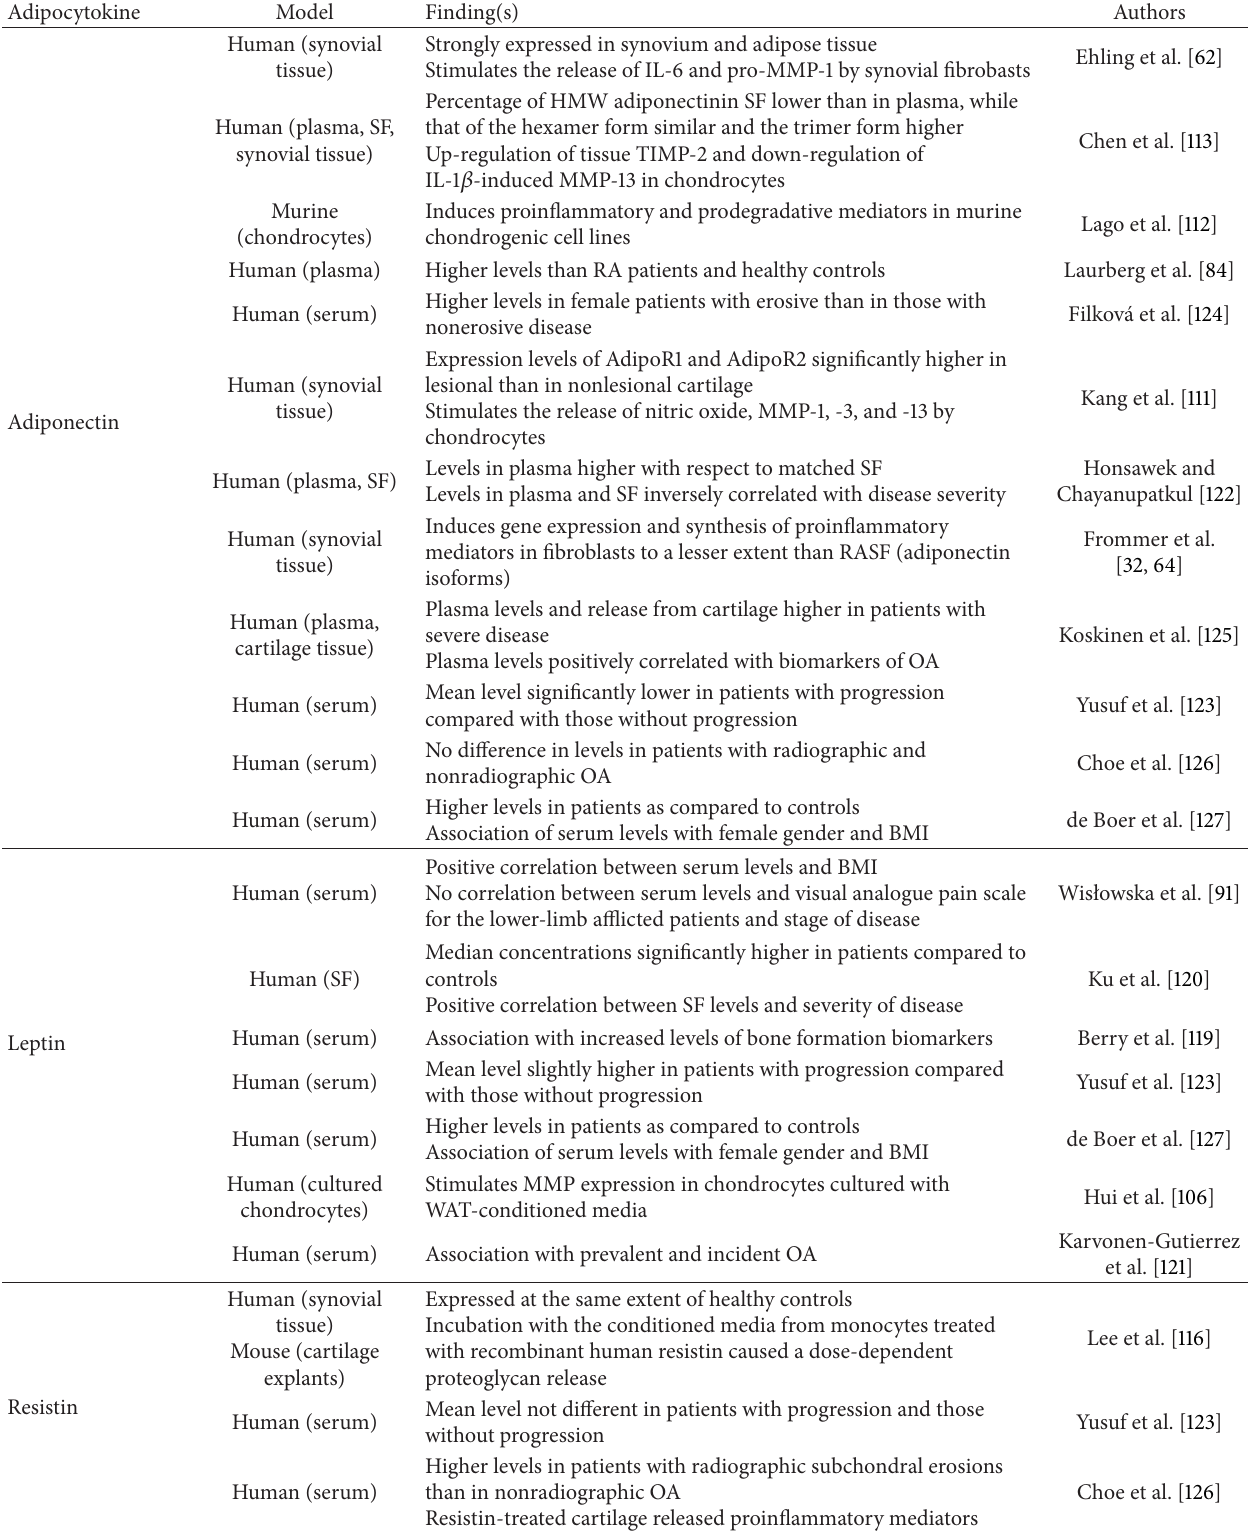
Table 3: Overview of main experimental and clinical data on adipocytokines in